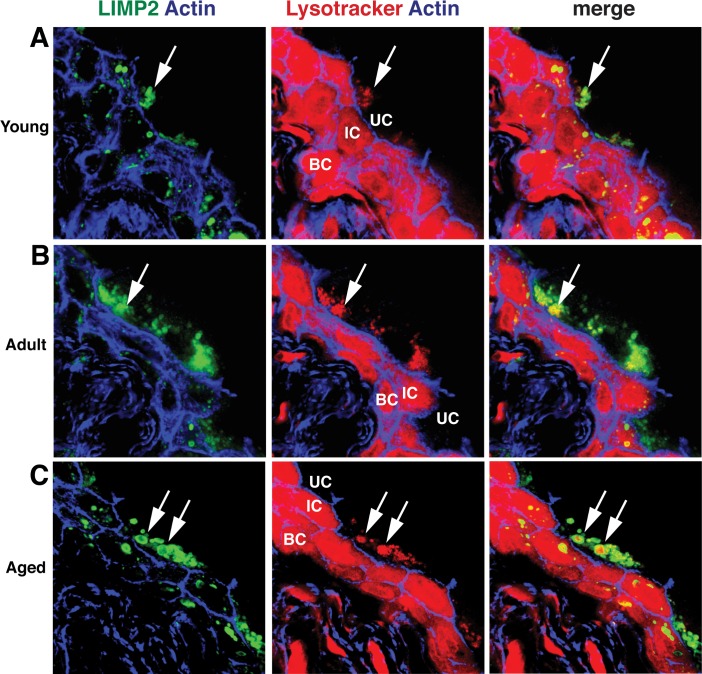
Lysotracker Red accumulates in endolysosomes.Immunofluorescence of young (A), adult (B), and aged (C) urothelium incubated with Lysotracker Red (red) and co-stained with antibodies to LIMP2 (green structures) and phalloidin (blue), which labels the cortical actin cytoskeleton. Large, Lysotracker Red-positive endolysosomes are marked with white arrows. Underlying intermediate (IC) and basal cells (BC) show non-specific cytoplasmic Lysotracker Red staining that did not appear in umbrella cells (UC).